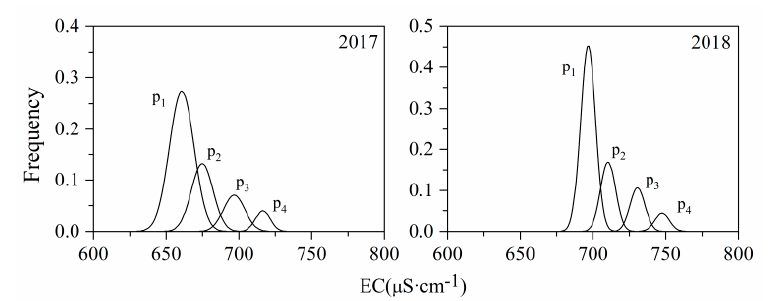
Figure 8. The CFDs of the Zhenzhu Spring. Table 4. List of peak area ratios of the CFDs in Tanxi Spring and Zhenzhu Spring.